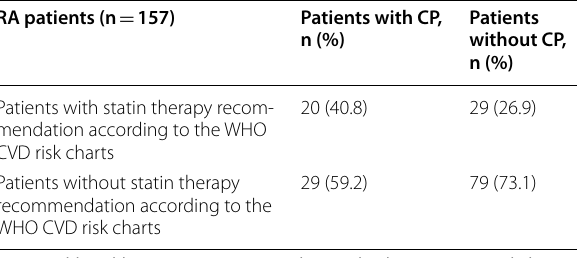
Table 2 Statin therapy recommendation according to the WHO